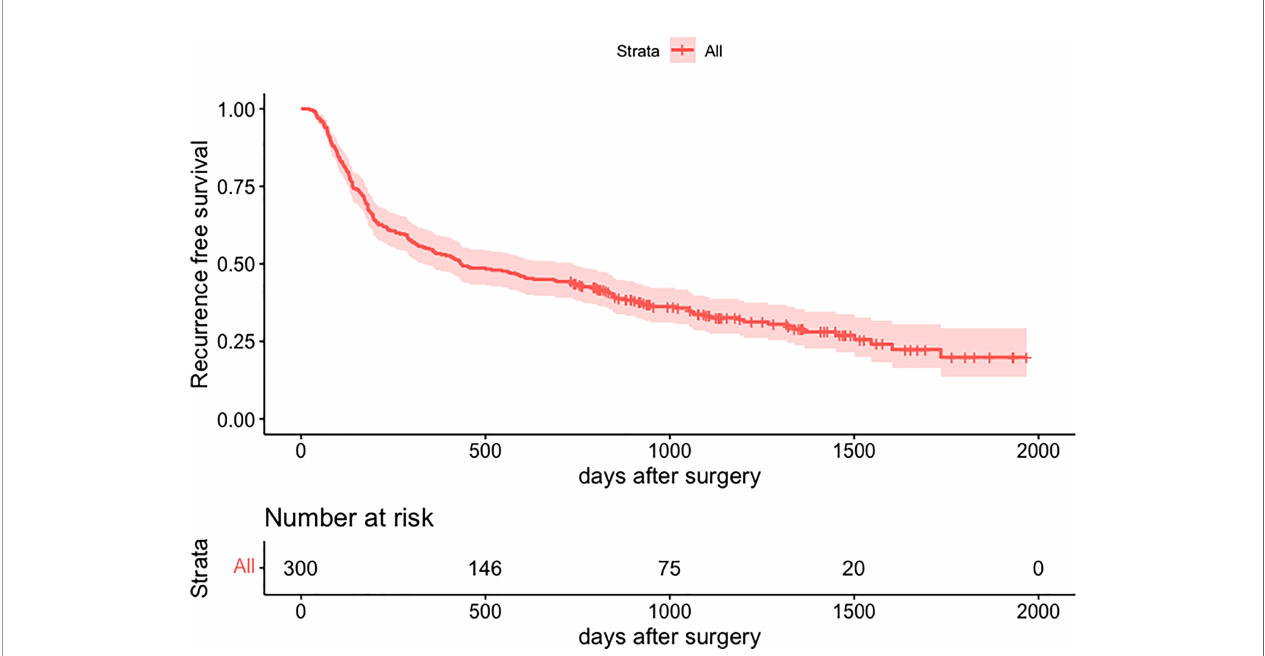
FIGURE 3 | Kaplan-Meier curve for recurrence-free survival of 300 patients. HCC, hepatocellular carcinoma.